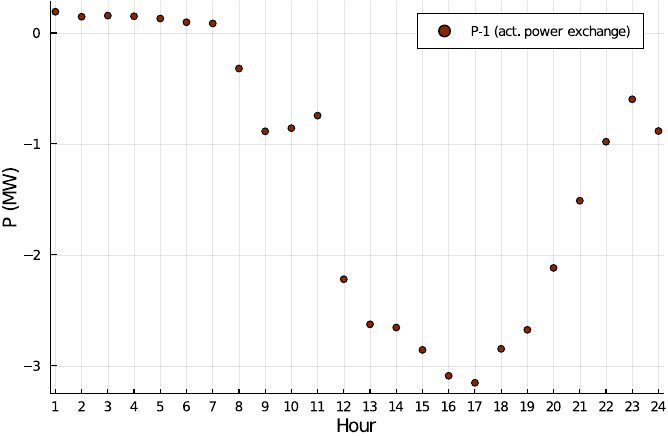
Figure 10. Active power exchange with the transmission system for the day under test in the case study.